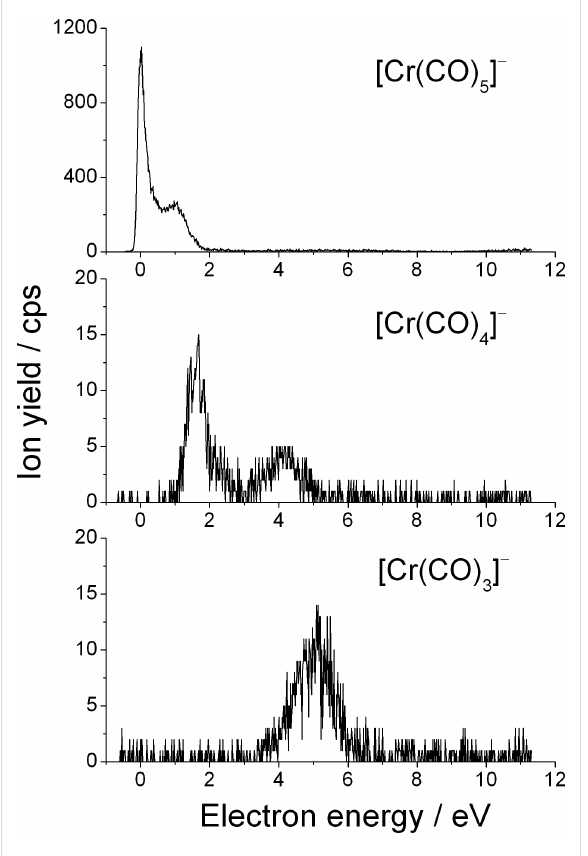
Figure 2: Yield of the fragment anions generated from DEA to chromium(0)